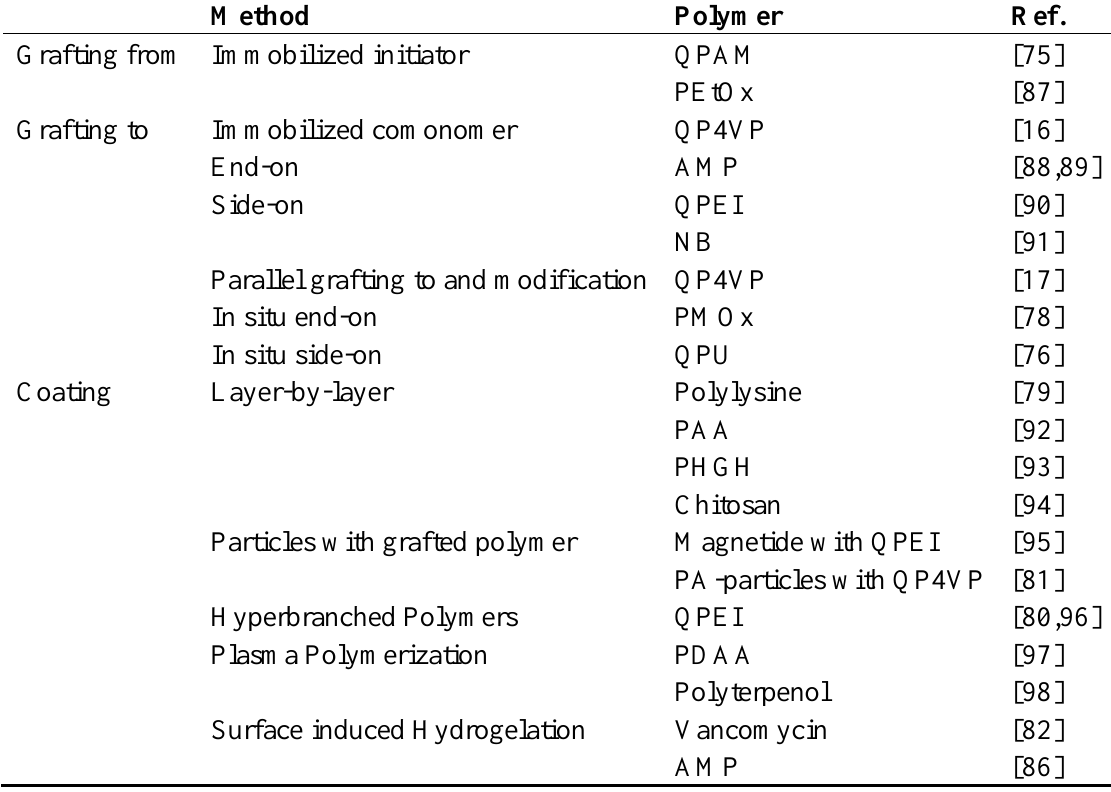
Table 1. Examples of surface attached biocidal